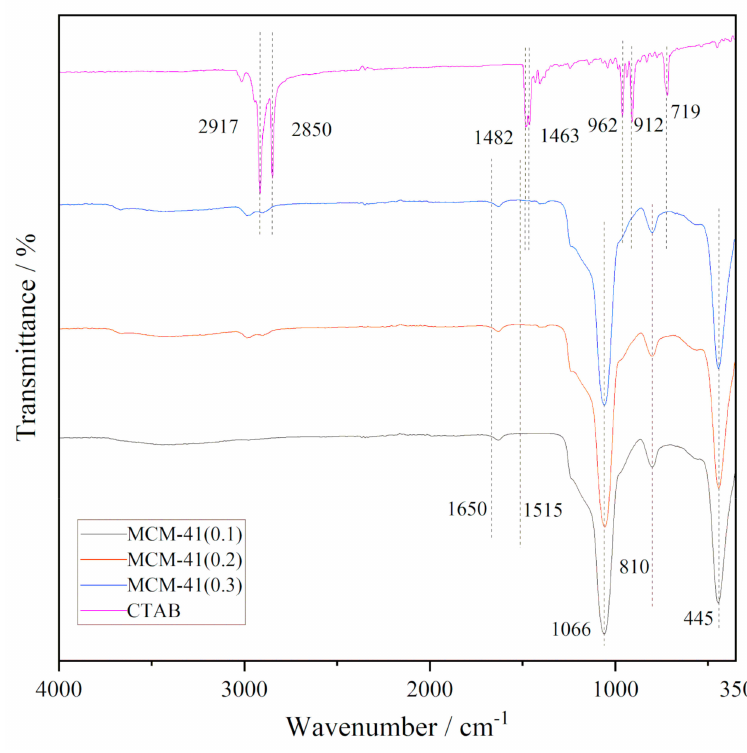
Figure 5. The FT-IR spectra of CTAB and